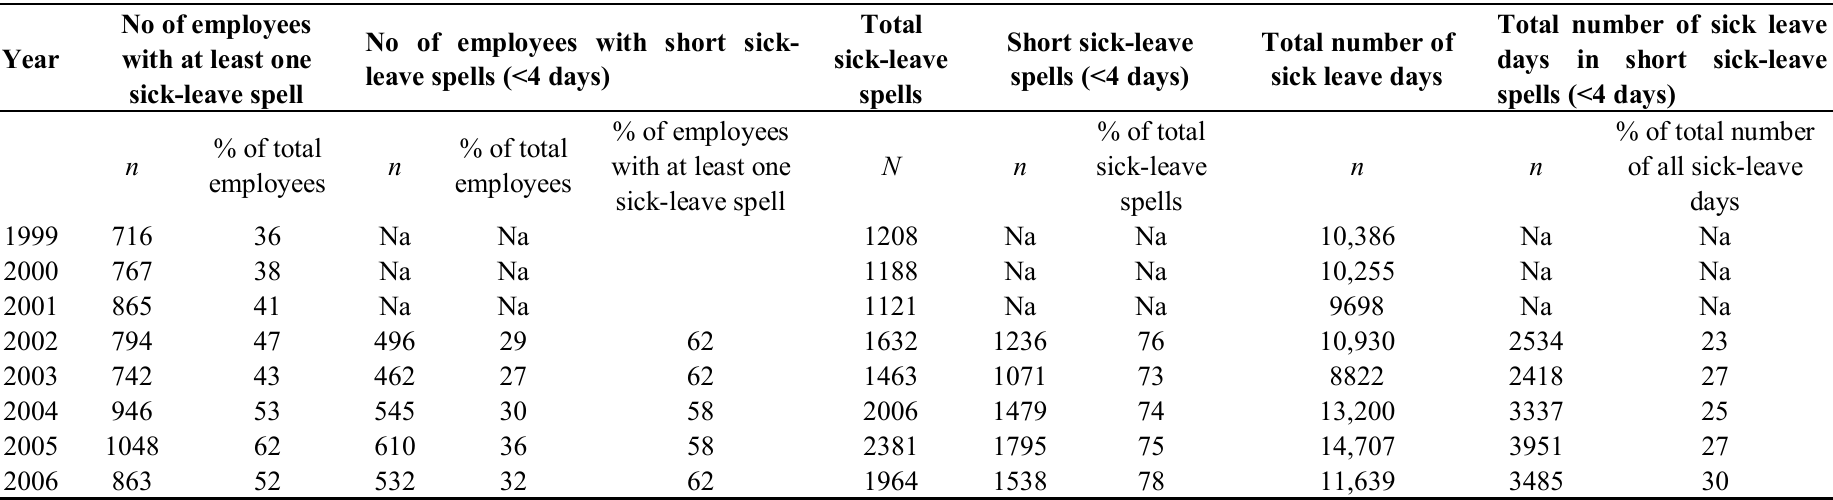
Table 2. Sickness absence in a shipyard industry in Greece in 1999 − 2006, presented by year using different measures of sickness absence. No of employees Year with at least one sick-leave spell